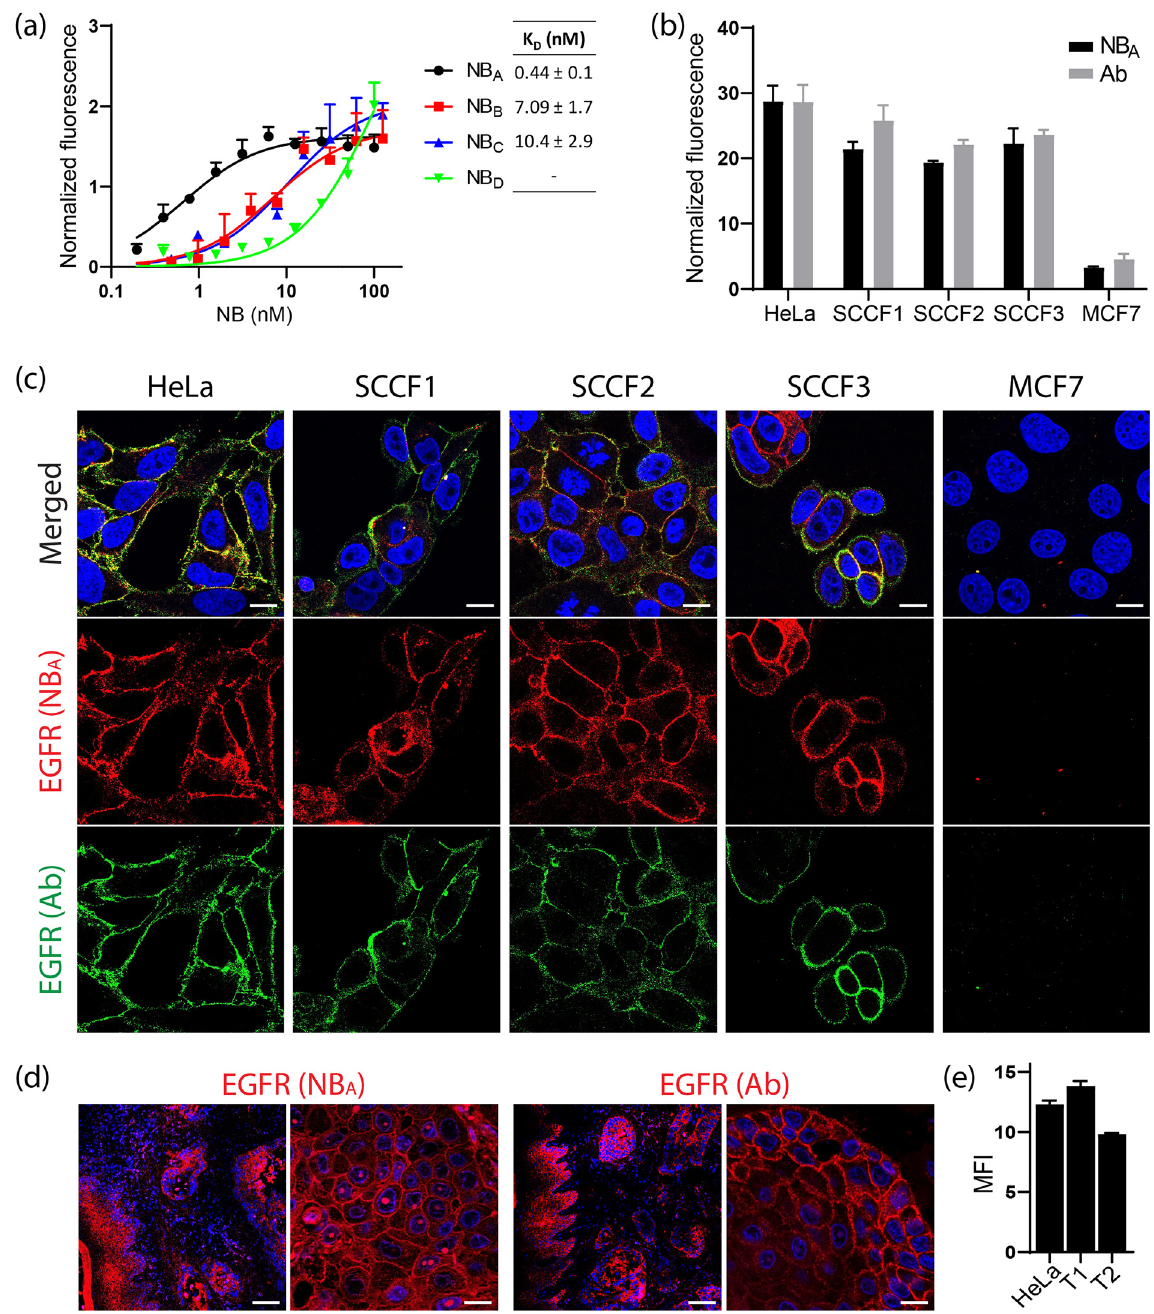
Figure 2: EGFR expression on human and feline cells and tissue detected by NB A . (a) A binding assay was performed with representative NBs, previously selected against human EGFR, using feline SCCF1 cells. The graph displays the normalized binding curves of several NBs to SCCF1 cells. The apparent binding affinities ( K D ) of the different NBs are shown. (b) and (c) Membrane EGFR was detected on three feline OSCC cell lines (SCCF1, SCCF2 and SCCF3) and two human cancer cell lines (HeLa and MCF7). (b) Membrane EGFR levels measured by fl ow cytometry using a commercial antiEGFR antibody or NB A -Alexa 647, expressed as median fl uorescence intensity and normalized based on HeLa cells. (c) Confocal microscope images of each cell line co-stained for membrane EGFR using NB A -Alexa 647 (red, middle panel) and a commercial species cross-reactive antibody (green, bottom panel). Nuclei were stained with DAPI(blue).Mergedimagesareshownonthetop panels.Scalebar,15µm.(d)FelineOSCCtissuesectionsstainedwith NB A -Alexa647(left)or a commercial antiEGFR antibody (right). Images show an overview of the OSCC tissue including adjacent normal oral epithelium, and a close- up of the tumor cells. Scale bar, 100 µm (left images) and 15 µm (right images). (e) Membrane EGFR was detected on HeLa cells and primary tissue samples of two feline OSCC cases (T1 and T2). EGFR levels were measured by fl ow cytometry using a commercial antiEGFR antibody, expressed as median fl uorescence intensity